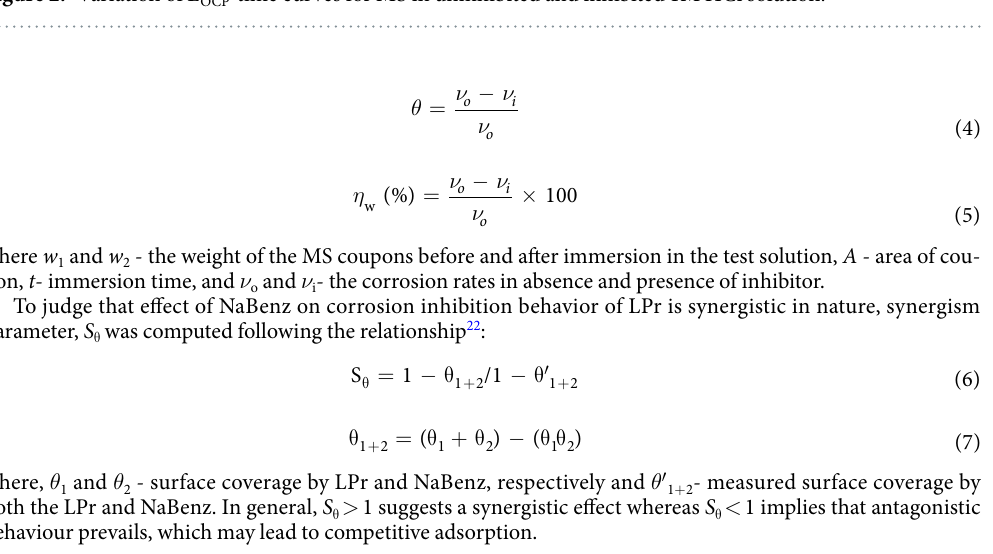
Figure 2. Variation of E OCP -time curves for MS in uninhibited and inhibited 1M HCl